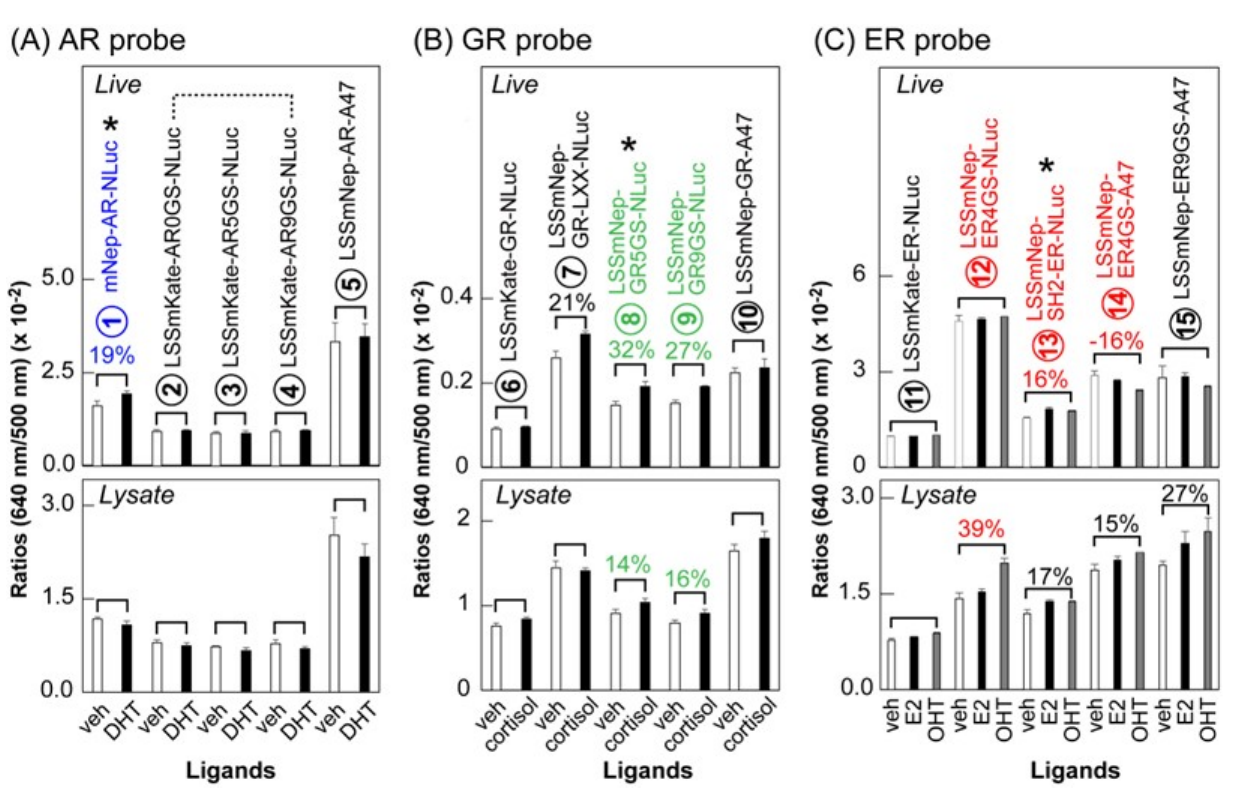
Figure 5. Initial screening of potential BRET probes for imaging steroid hormones. The upper panel shows the optical responses of each BRET probe in live COS-7 cells, and the lower panel shows the same in cell lysates. ( A ) Variance in the optical intensities of BRET probes sandwiching AR HLBD, stimulated by vehicle or DHT. ( B ) Variance in the optical intensities of BRET probes sandwiching GR HLBD, which were stimulated by vehicle or cortisol. ( C ) Variance in the optical intensities of BRET probes sandwiching ER HLBD, which were stimulated by vehicle, E2, or OHT. Abbreviations: AR HLBD, The hinge and ligand binding domain of human androgen recepter; ER HLBD, The hinge and ligand binding domain of human estrogen recepter; GR HLBD, The hinge and ligand binding domain of human glucocorticoid recepter; 0-9GS, Glycine and serine linker in the size of 1–9; LXX, An LXXLL motif (where L is leucine and X is any amino acid); veh, vehicle; DHT, 5 α -dihydrotestosterone; E2, 17 β -estradiol; and OHT, 4-Hydroxytamoxifen. The asterisks (*) highlight the best S/B ratio probes in the groups.